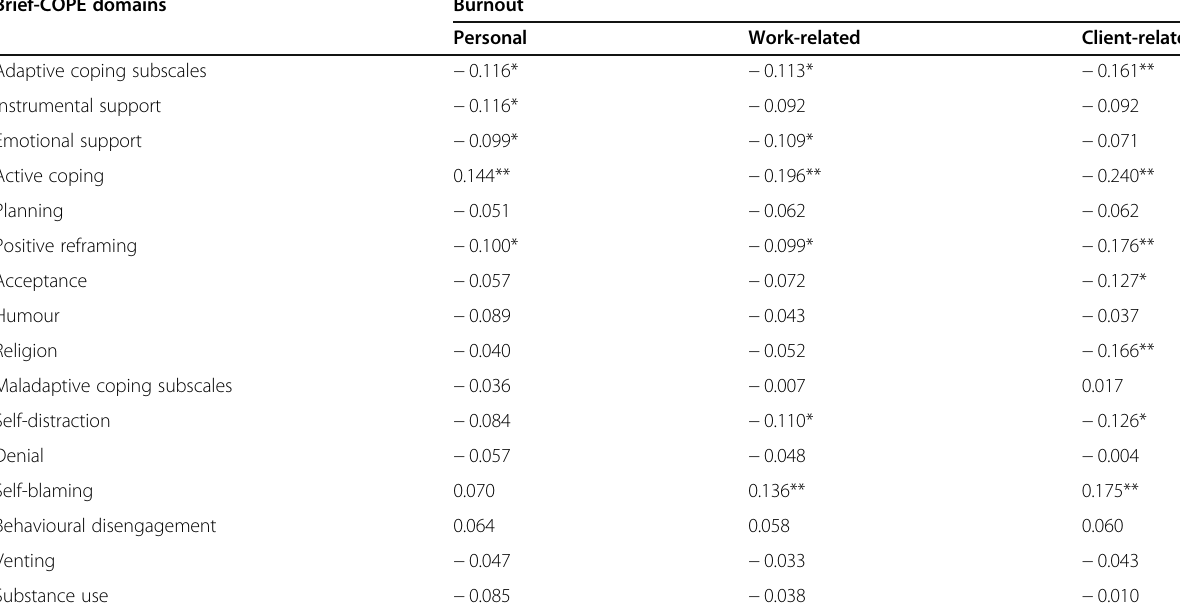
Table 2 Correlations (Pearson ’ s r ) between the CBI dimensions and Brief-COPE domains ( n =